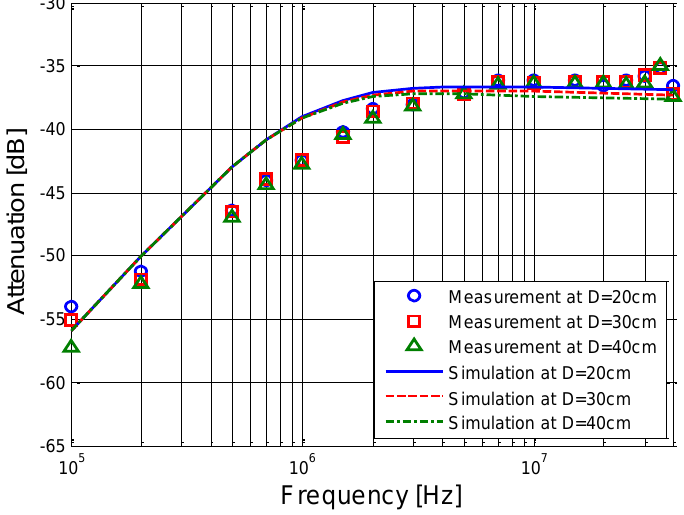
Figure 9. Comparison between measurements and simulation results corresponding to the different signal transmission distances.